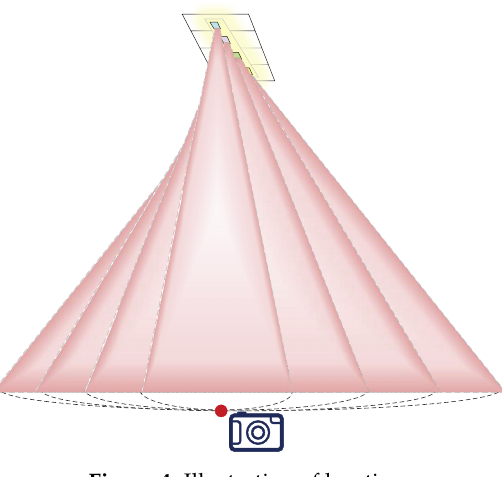
Figure 4. Illustration of location.